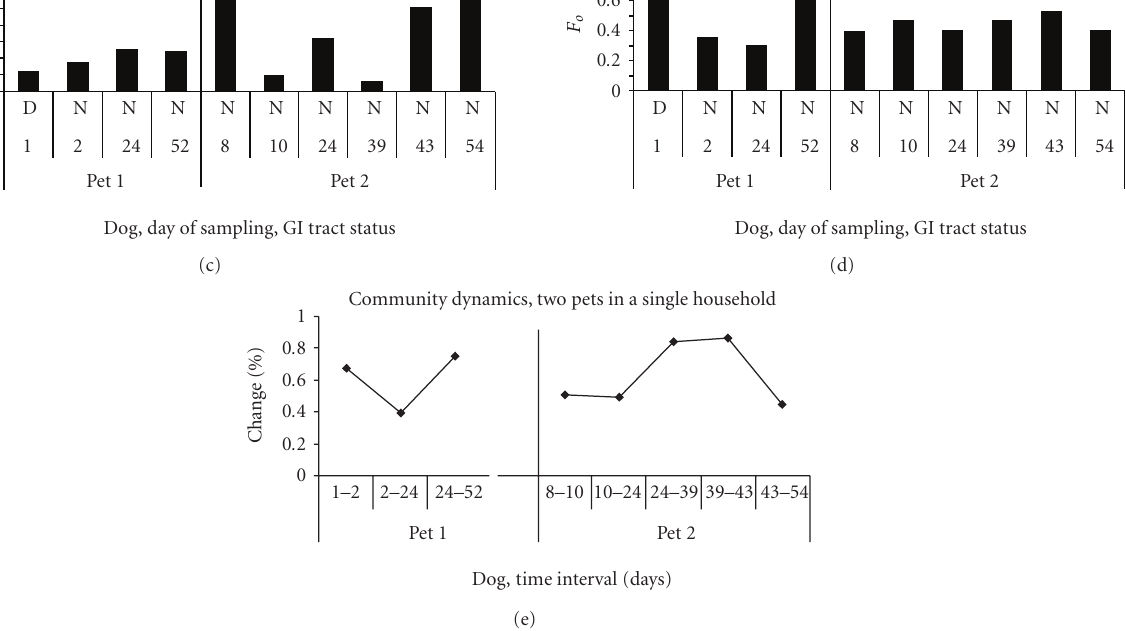
Figure 3: T-RFLP analysis of fecal samples from two pets in a single household . Panel (a) community composition expressed as % area of peaks under the T-RFLP electropherogram; bacterial groups were combined at the taxonomic level of order. Panel (b) dendrogram based on Bray-Curtis similarities of community composition among the samples from the two dogs; numbers at nodes indicate percentage of trees having an equivalent node in jackknife analysis. Panel (c) community richness parameter, Rr . Panel (d) community functional organization, Fo . Panel (e) % change parameter for community